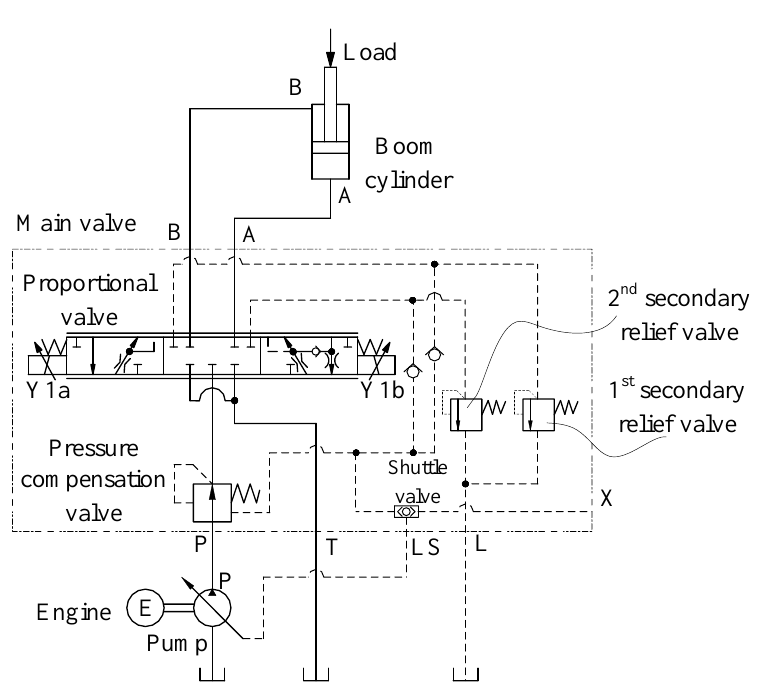
Figure 1. The original load sensing system for a conventional hydraulic excavator boom.